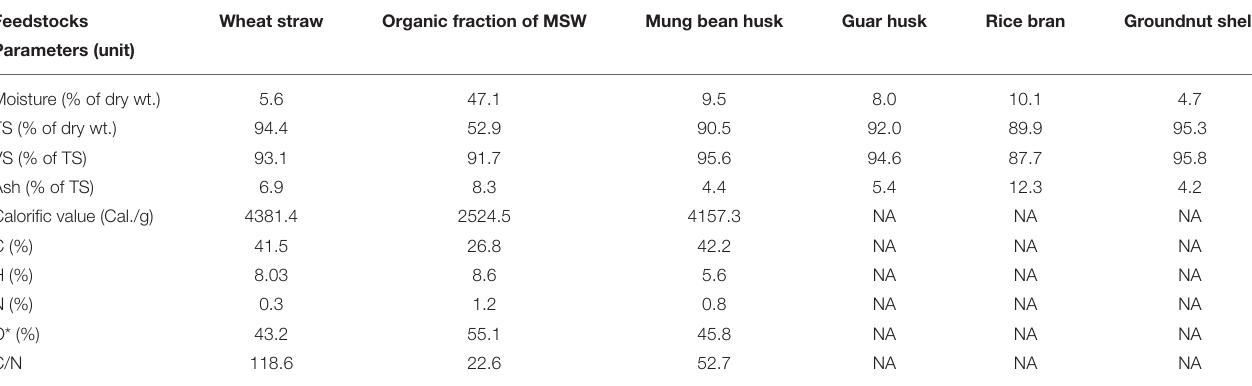
TABLE 1 | Characterization of feed-stocks. Feedstocks Wheat straw Organic fraction of MSW Mung bean husk Rice bran Groundnut shell Parameters (unit) Moisture (% of dry